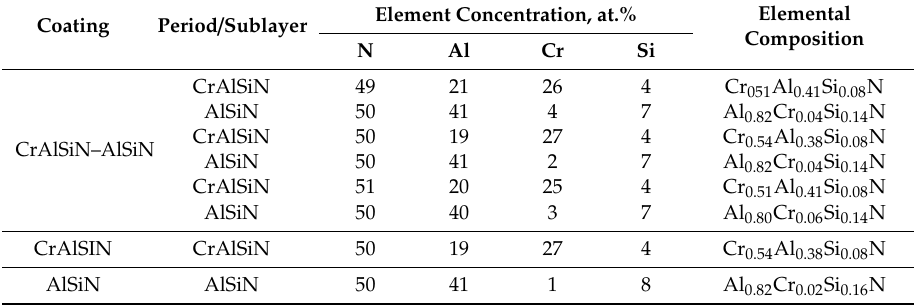
Table 1. Element composition of the modulated CrAlSiN–AlSiN and reference CrAlSiN and AlSiN